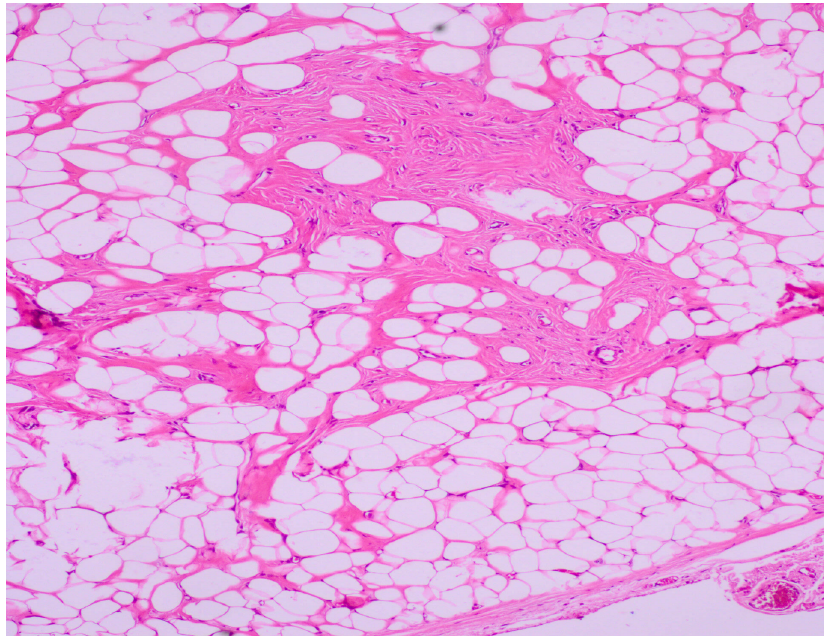
Figure 2: Microphotography of the specimen showing encapsulated tumor mass and mature adipocytes separated by a vascular patch (H & E stain;